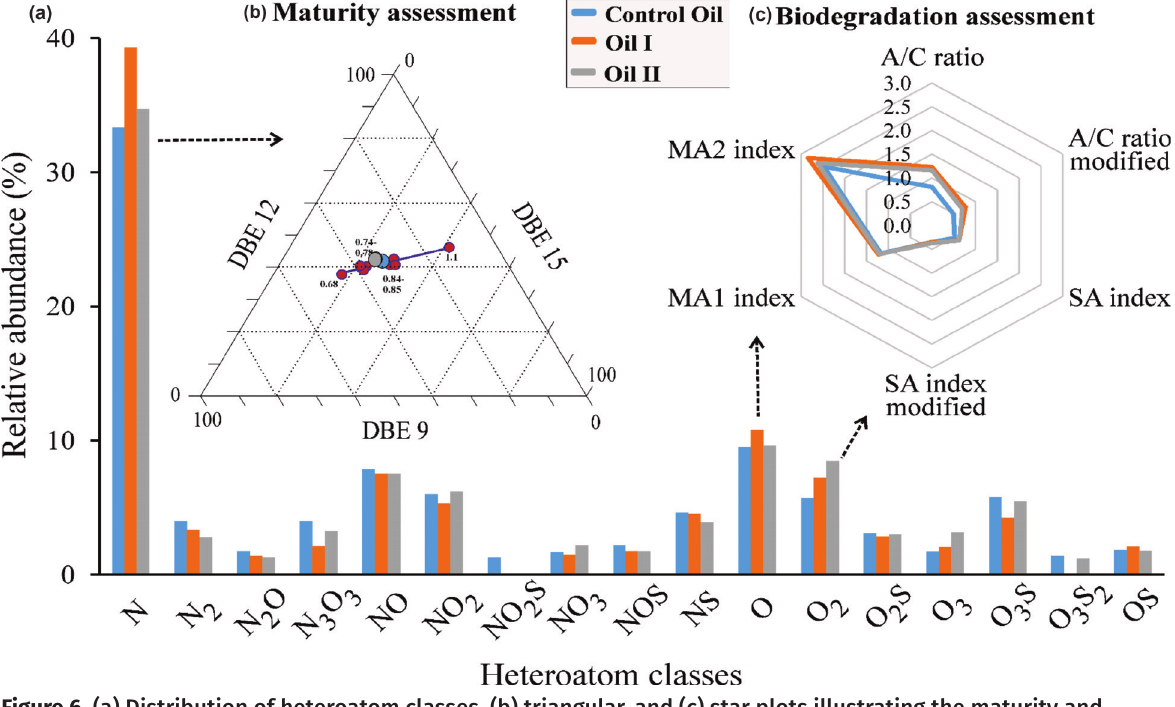
Figure 6. (a) Distribution of heteroatom classes, (b) triangular, and (c) star plots illustrating the maturity and biodegradation assessment, respectively, for the oil